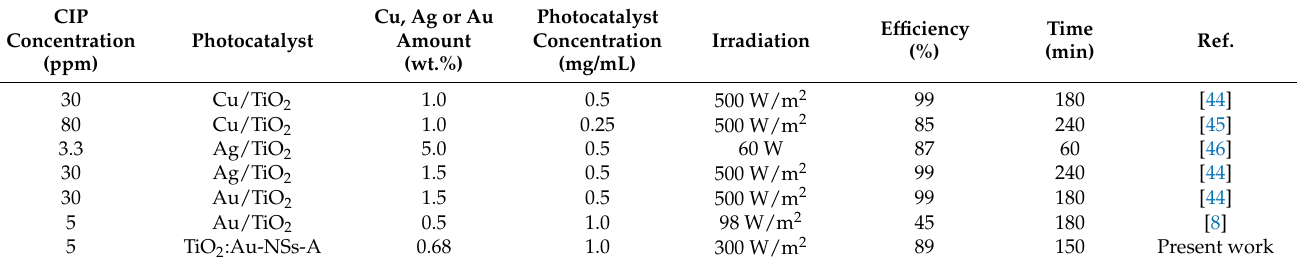
( k ) under 150 min blue, green, red and NIR radiation for TiO 2 :Au-NSs-A, B, and C nanoparticles.